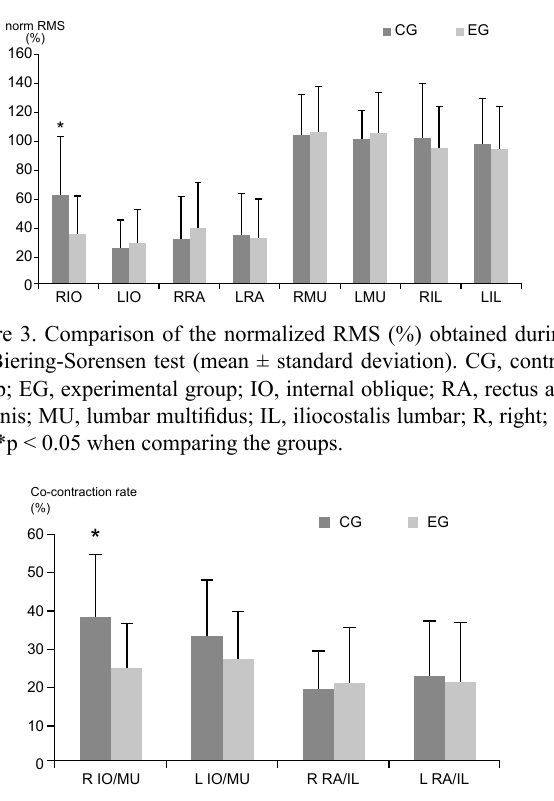
Figure 4. Comparison of the co-contraction rate (%) obtained during the Biering-Sorensen test (mean ± standard deviation). CG, control group; EG, experimental group; IO, internal oblique; RA, rectus ab - dominis; MU, lumbar multifidus; IL, iliocostalis lumbar; R, right; L, left; *p < 0.05, when comparing the